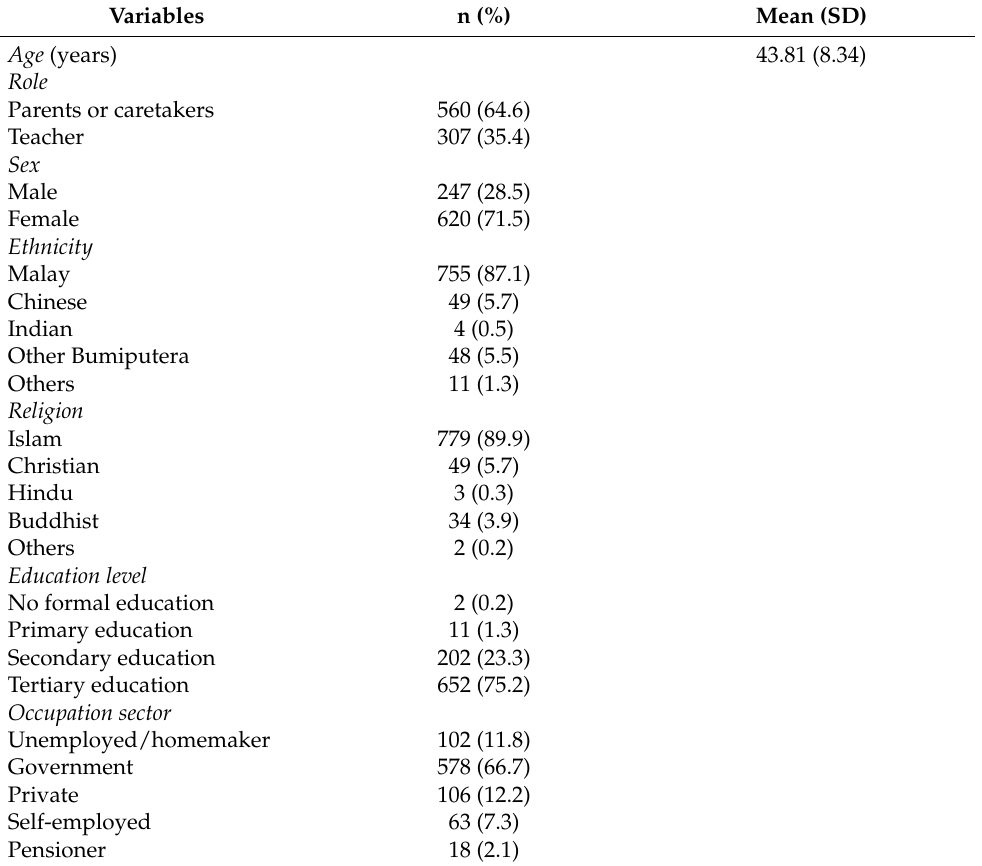
Table 1. Descriptive analysis of each sociodemographic factor of the study population (n =